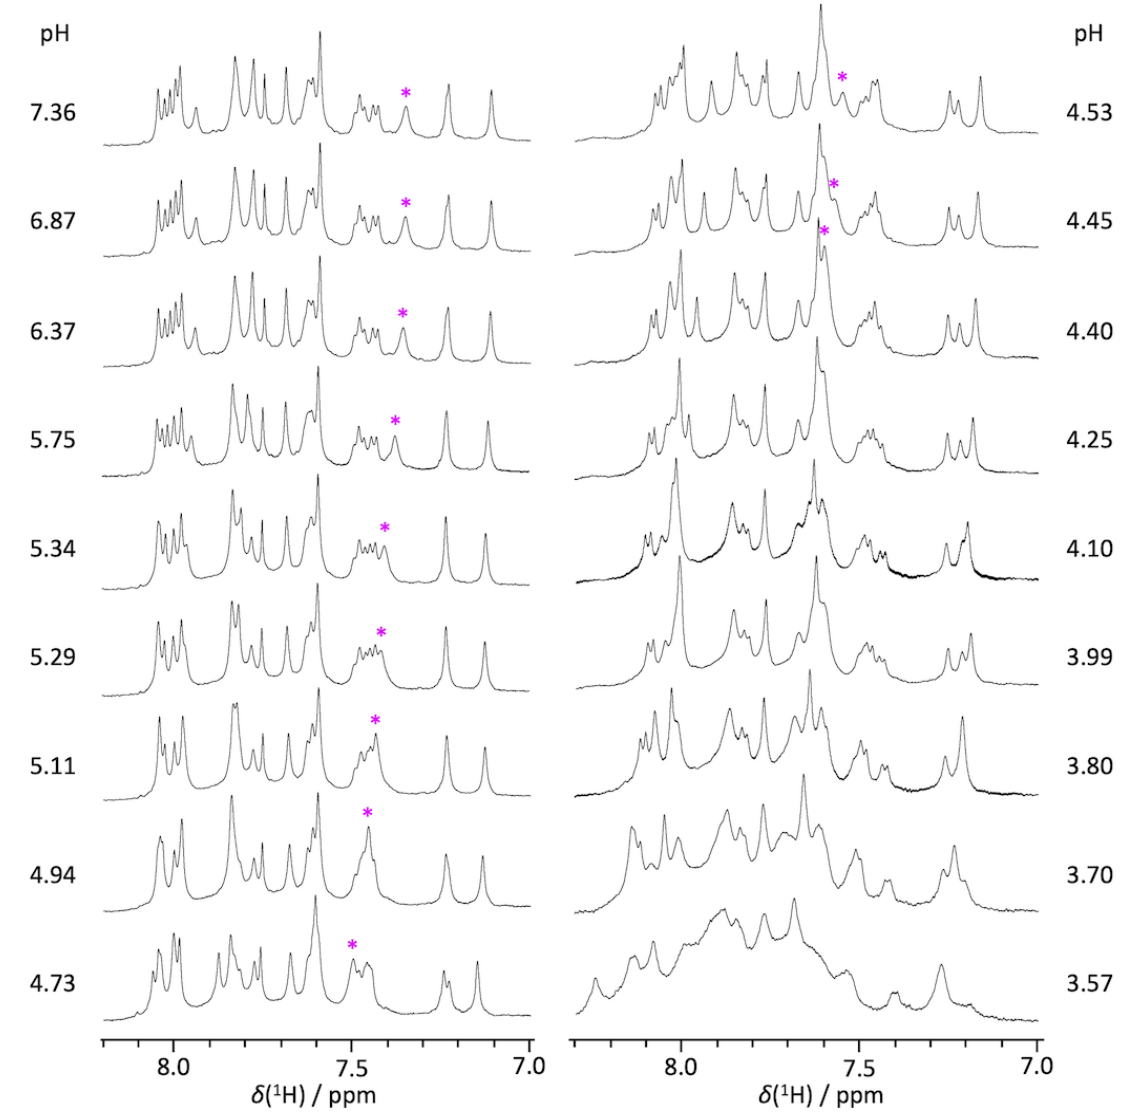
Figure 6. One-dimensional 1 H NMR spectra of the model RNA duplex 1 against various pH (acidic region) in the absence of CdCl 2 . The H8(G10.1*) resonance is labeled with a magenta asterisk in each spectrum. Although chemical shift perturbations for several resonances except for H8(G10.1*) resonance were observed, these resonances were assigned to terminal residues. Below pH 3.70, denaturation of the duplex was evident. To assure the trace of the NMR signals of base protons, a natural abundance 1 H- 13 C HSQC spectrum was recorded at pH 4.40 (Figure S5). The best-fit theoretical curve indicated that the p K a value for N7(G10.1*) was